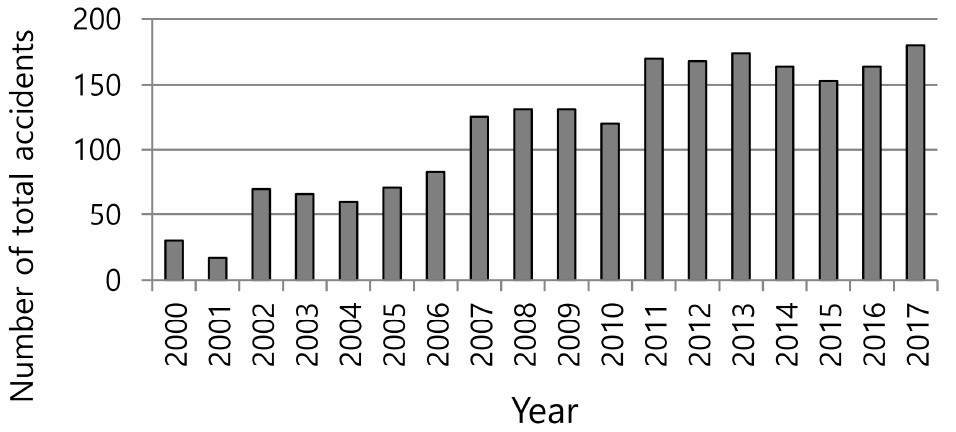
Figure 13. Yearly statistics on wind turbine damages around the world [81].